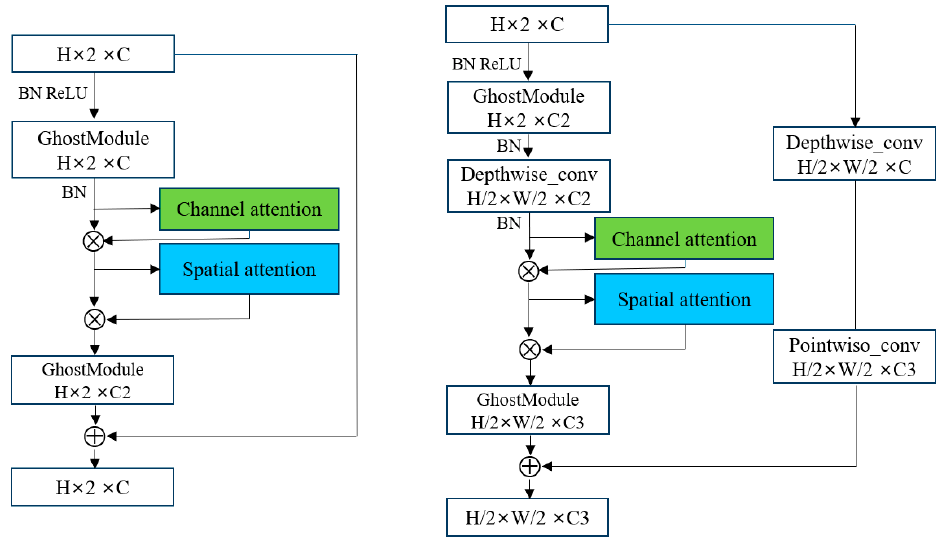
Figure 8. The two G-Bneck structures. ( a ) Stride=1 bottleneck. ( b ) Stride=2 bottleneck.